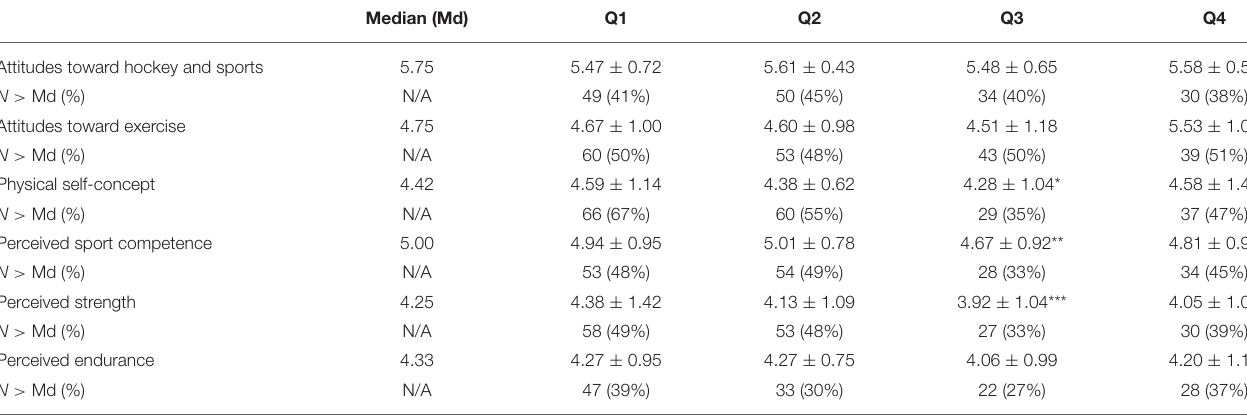
TABLE 3 | Comparisons of birth quartiles regarding physical self-concept and attitudes toward physical